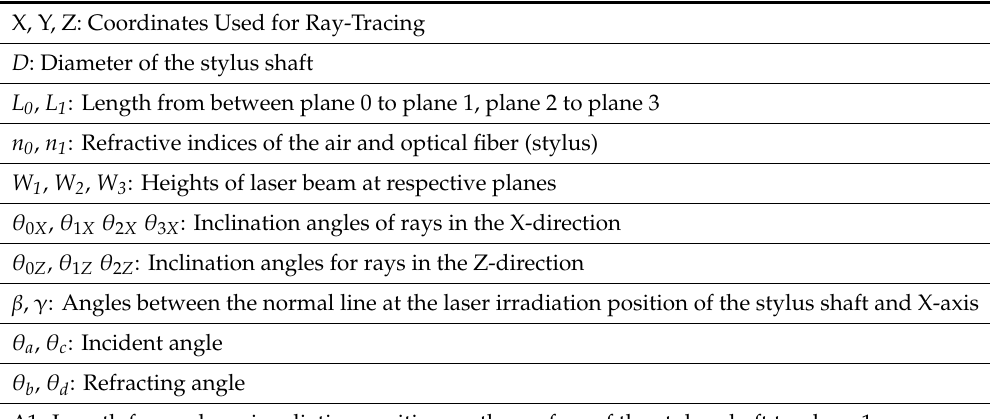
Table 2. Parameters used for ray-tracing.